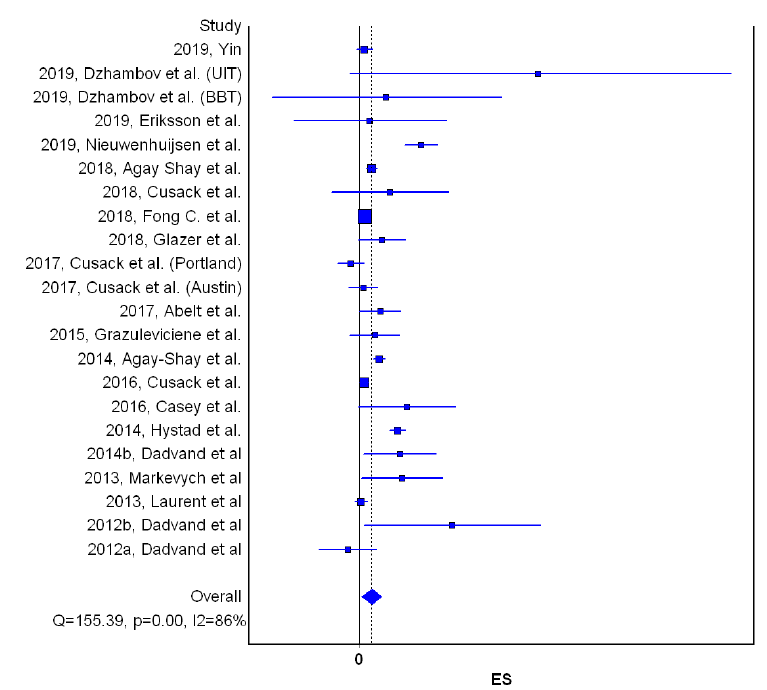
Figure 1. Forest plot on the e ff ect of residential greenness (NDVI) on birthweight (standardized regression coe ffi cients, quality e ff ects model). Note: ES—e ff ect size; Q and I2—heterogeneity statistics. Horizontal lines, square and diamond symbols are indicating confidence intervals, e ff ect estimates, and overall e ff ect, respectively. Table 2. Meta-Analysis Results for the e ff ect of NDVI increase on small for gestational age (odds